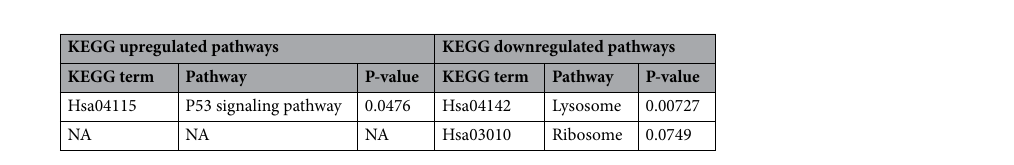
Table 7. KEGG Upregulated and Downregulated